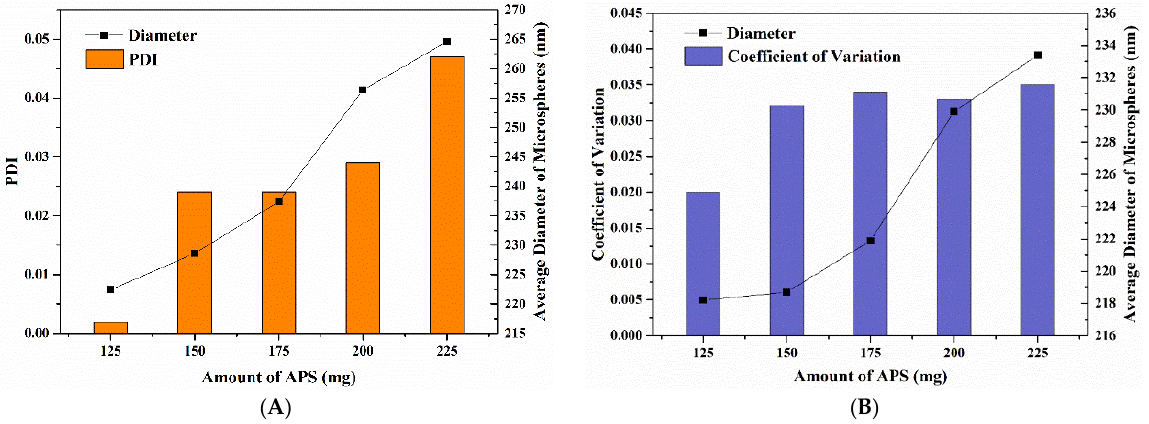
Figure 4. The particle size analysis of P(St-AA) colloidal microspheres synthesized with different amounts of APS: ( A ) by DLS characterization; ( B ) by measuring FE-SEM images. The FE-SEM images of P(St-AA) colloidal microspheres (Figure 5) synthesized with 125 and 150 mg APS, showed that the samples had only point and line defects; however, the samples with 175 – 225 mg APS had larger cave-like defects. The pore area increased upon adding more APS and significantly decreased the order, which may be related to increase of particle size and surface functional groups of microspheres [18]. Figure 5. FE-SEM images of P(St-AA) colloidal microspheres synthesized with different APS amounts: ( A ) 125 mg; ( B ) 150 mg; ( C ) 175 mg; ( D ) 200 mg; ( E ) 225 mg. In this study, the coefficients of variation of P(St-AA) microspheres synthesized with different APS dosages were all less than 0.035 and showed a uniform distribution (Figure 4B). The average diameter of microspheres obtained by DLS and manual measurement was in the ranges of 220 – 265 nm and 218 – 234 nm, respectively. When the amount of APS